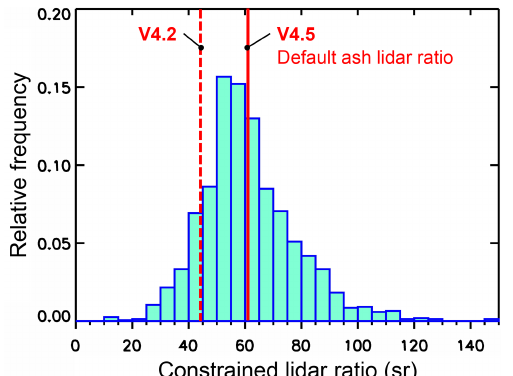
Figure 13. Distribution of 532nm lidar ratios retrieved from con- strained retrievals of ash layers from several volcanic events (see text). Lines indicate default values for ash in V4.2 and